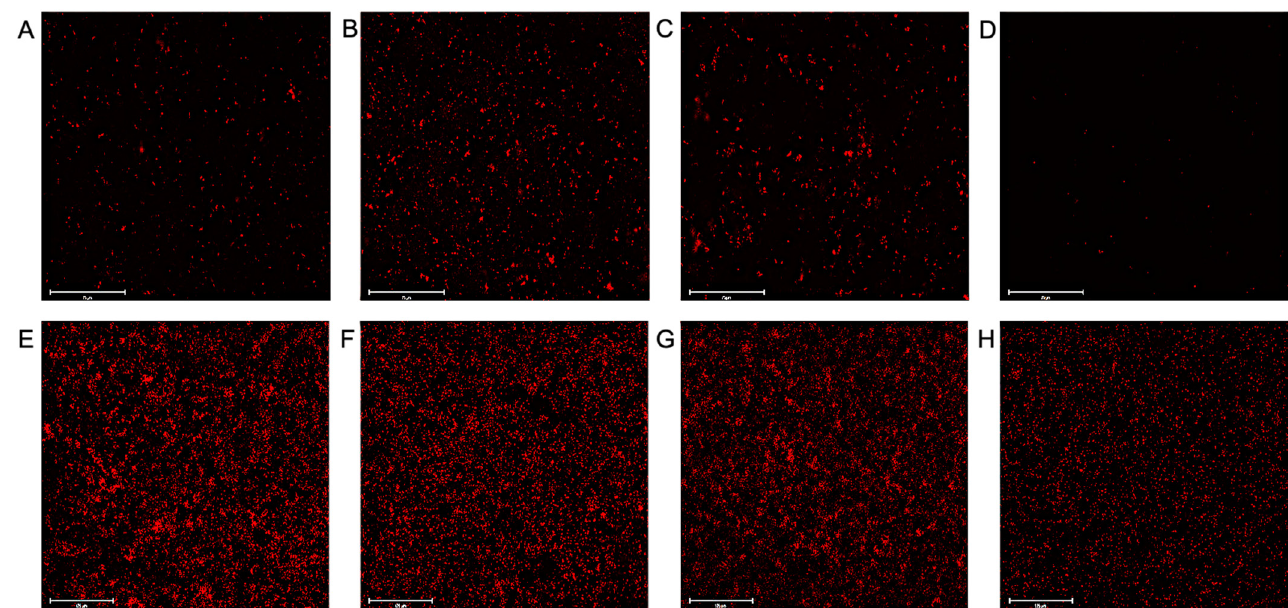
Figure 6. Visualization of LL-37 and PMB individual versus combined treatment of E. coli MG1655 and P. aeruginosa PAO1 pre-grown biofilms. E. coli MG1655 and P. aeruginosa PAO1 biofilms were